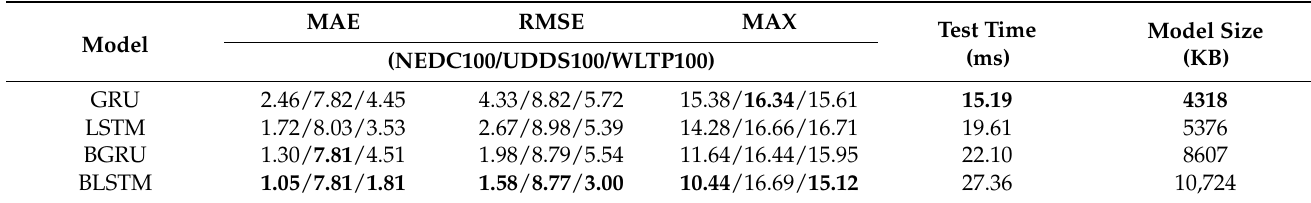
Table 3. The statistical results of scenario